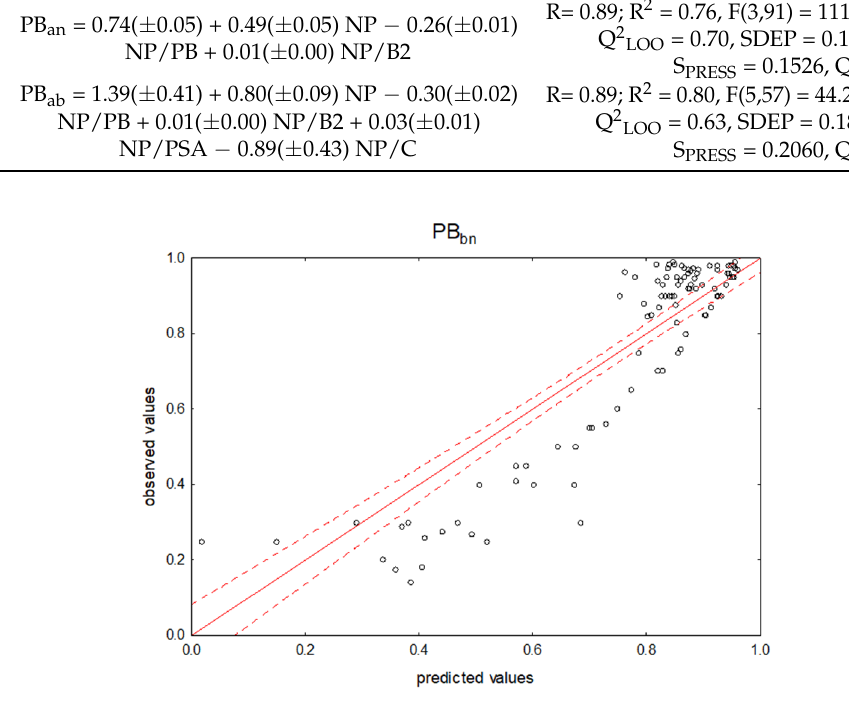
Figure 2. Predicted vs. observed values for the MLR model using NP TLC retention data. Dependent variable: PB bn .